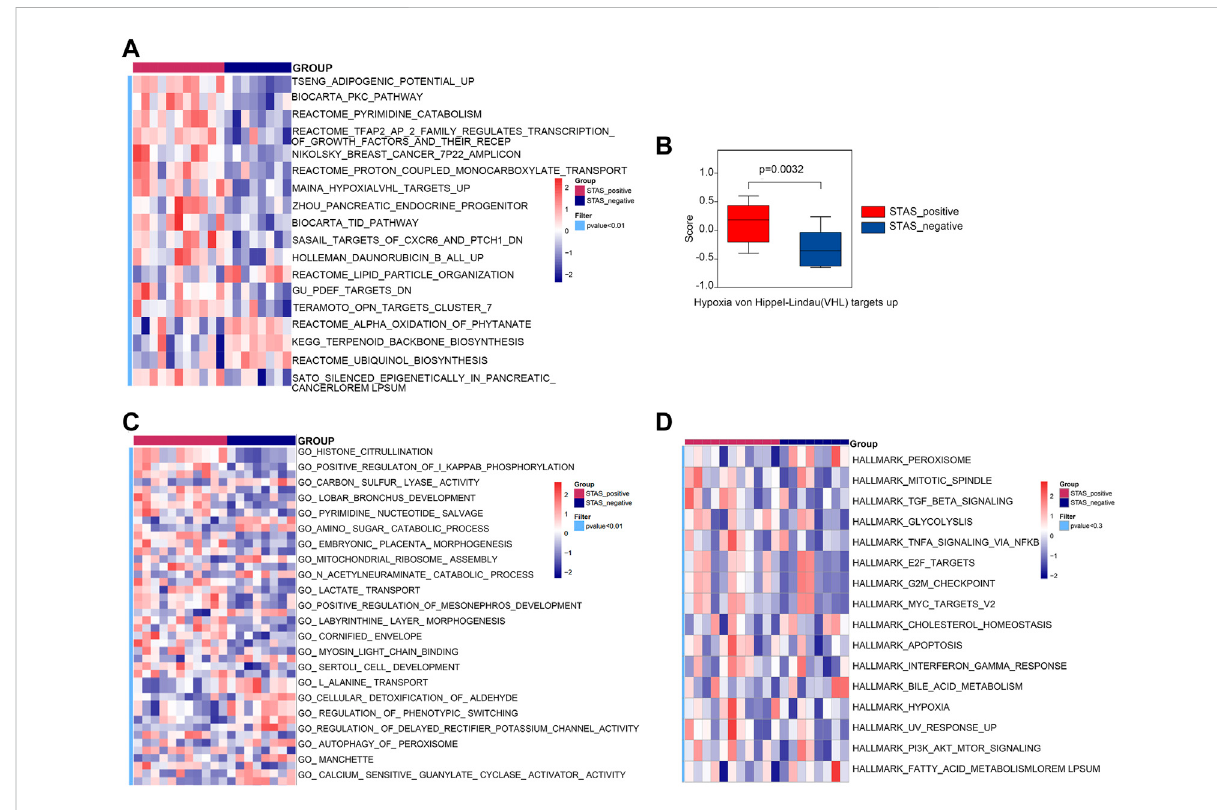
FIGURE 6 Gene set variation analysis (GSVA) between STAS_positive and STAS_negative groups. (A) Heat map derived by C2 gene set. (B) Box plot of Hypoxia VHL targets up. (C) Heat map derived by C5 gene set. (D) Heat map derived by Hallmark gene